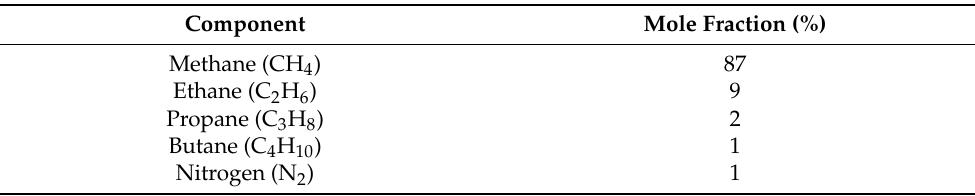
Table 2. Composition of Kuwait natural gas used in this study [20].